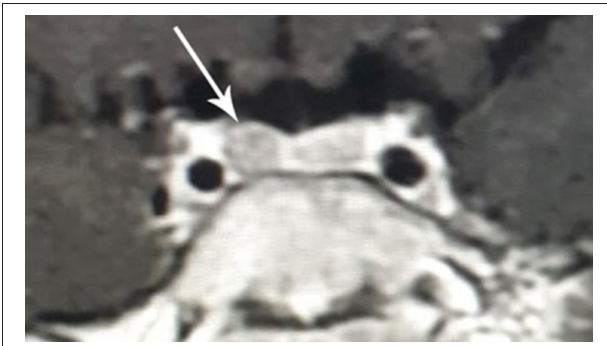
Frontiers in Endocrinology |